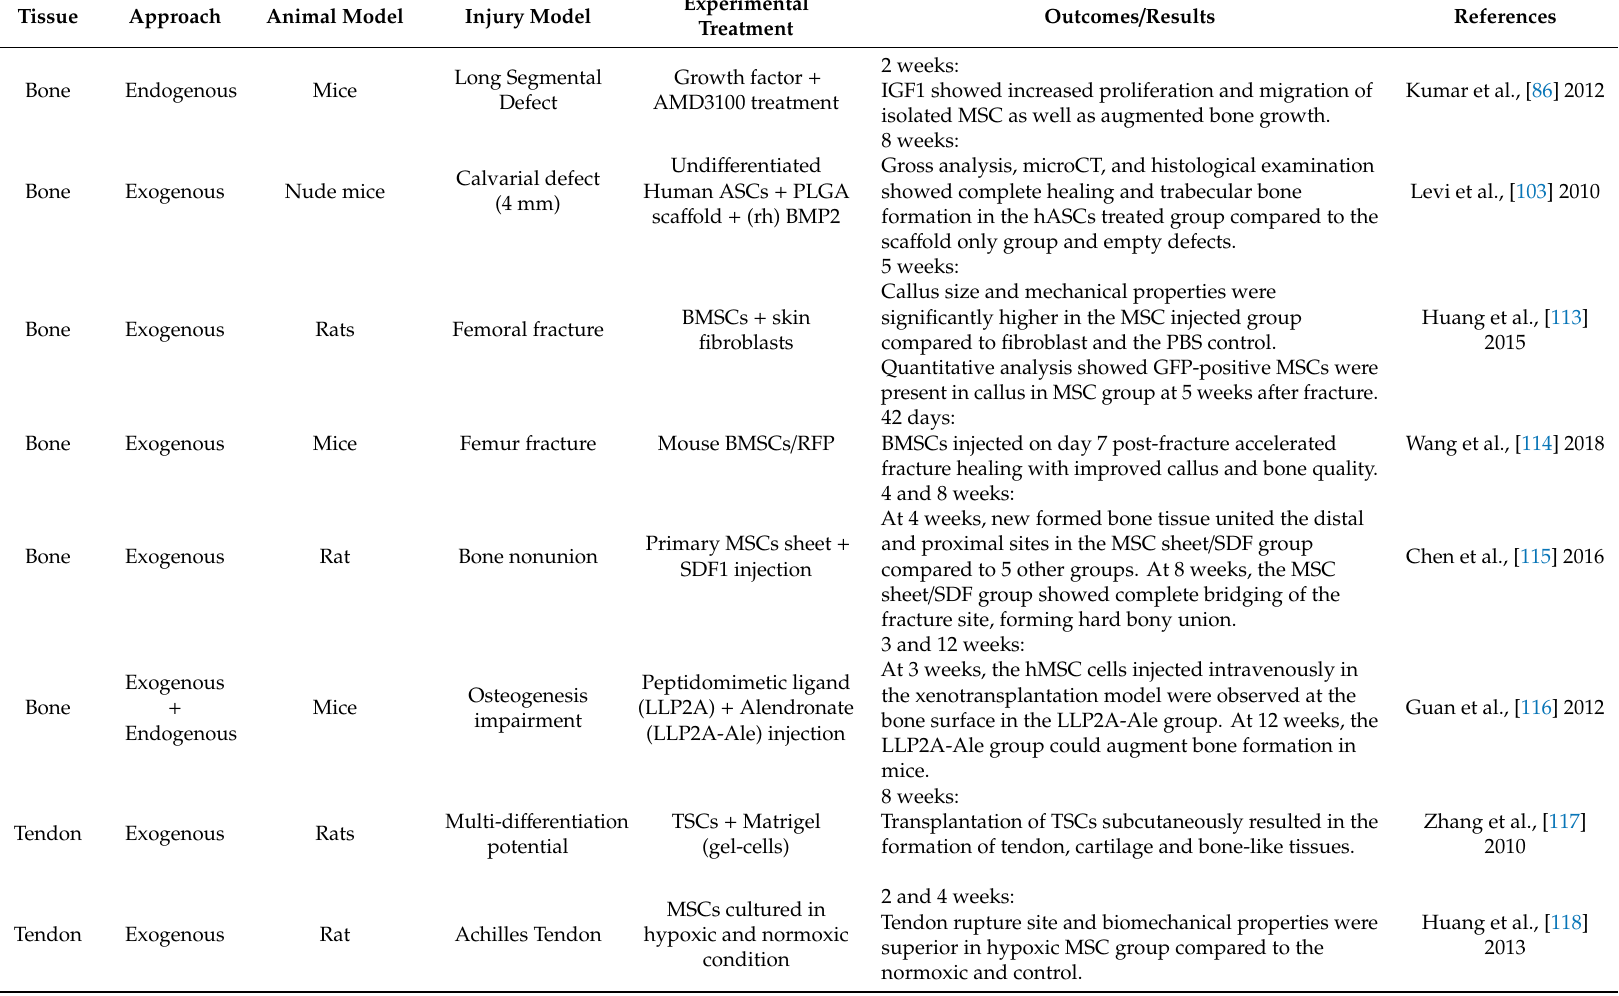
Table 1. Pre-clinical studies of endogenous and exogenous use of stem / progenitor cells in skeletal